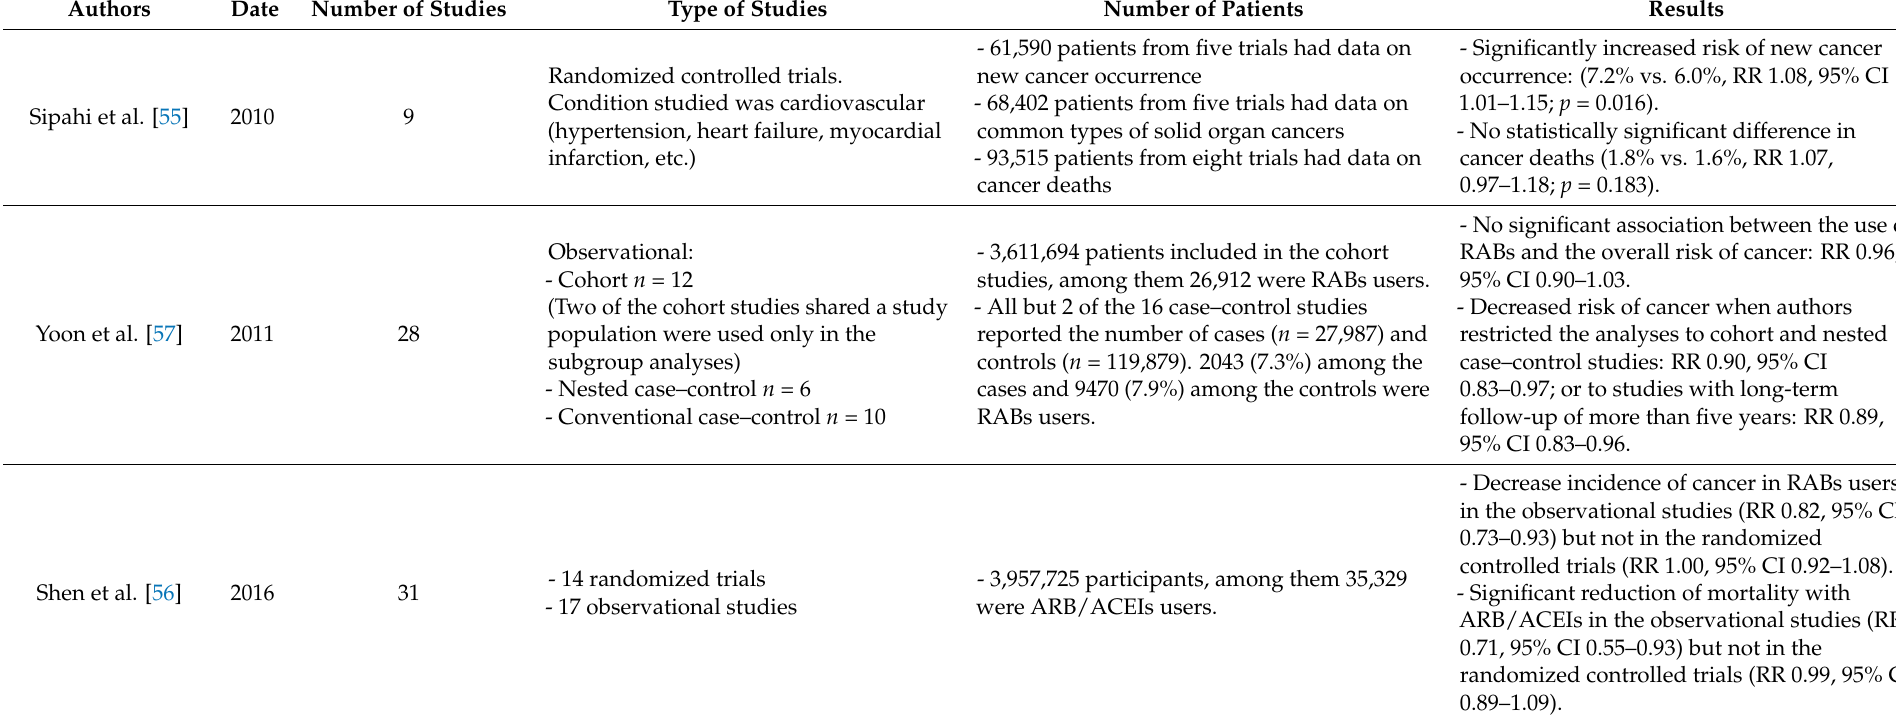
Table 1. Summary of meta-analyses of RABs use and overall risk of cancer occurrence. Abbreviations: ACEIs: angiotensin-converting enzyme inhibitors, ARBs: angiotensin-2 receptor blockers, CI: confidence interval, HR: hazard ratio, OR: odds ratio, RABs: renin-angiotensin system blockers, RR: risk